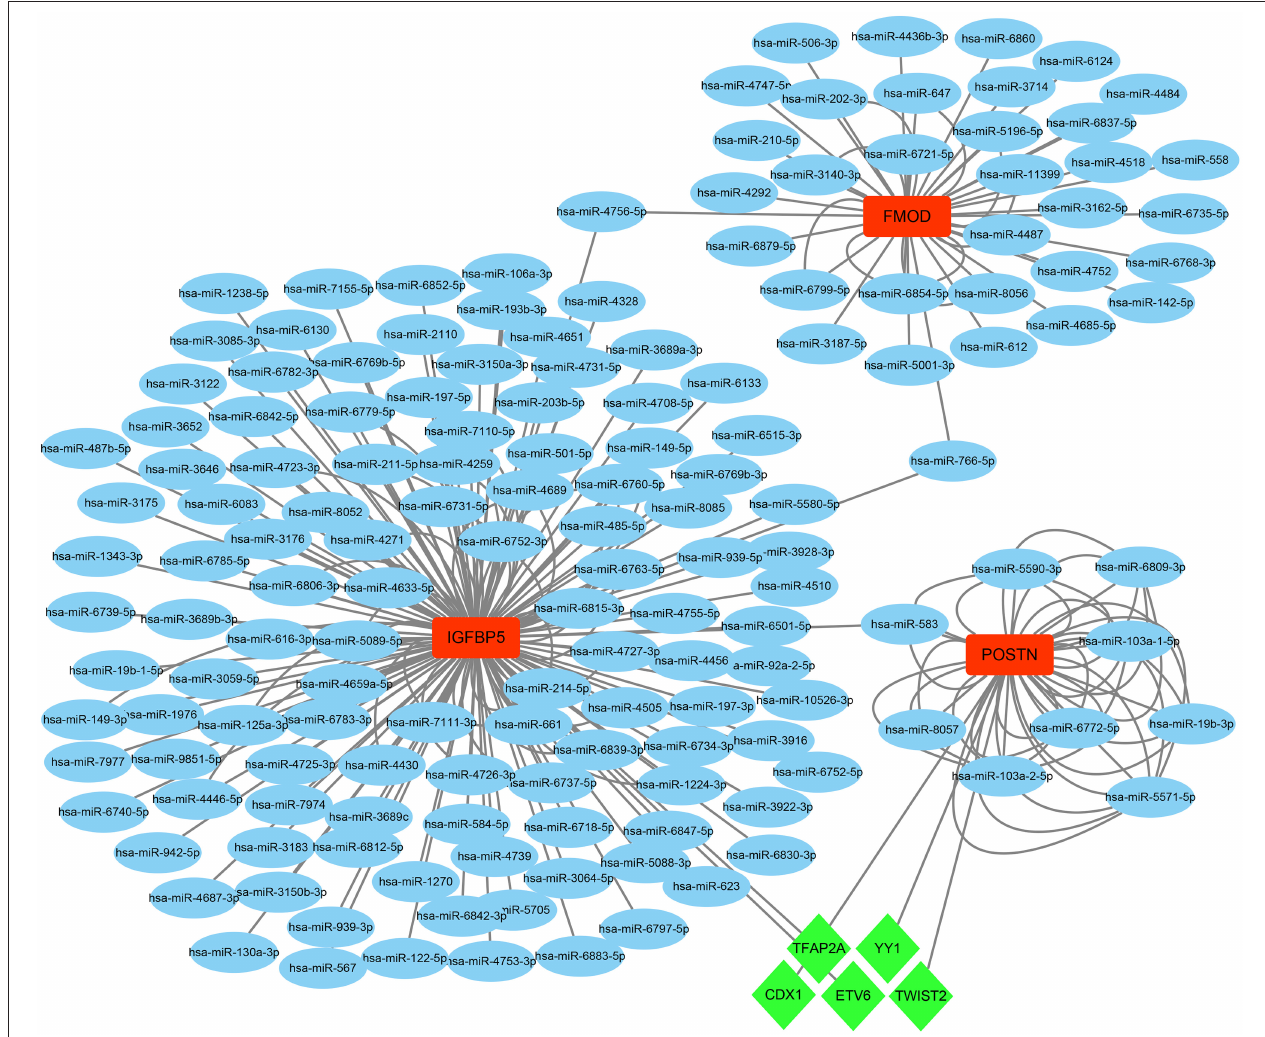
FIGURE 9 | The TF–mRNA–miRNA regulation network of hub genes was constructed using the MiRwalk and TRRUST